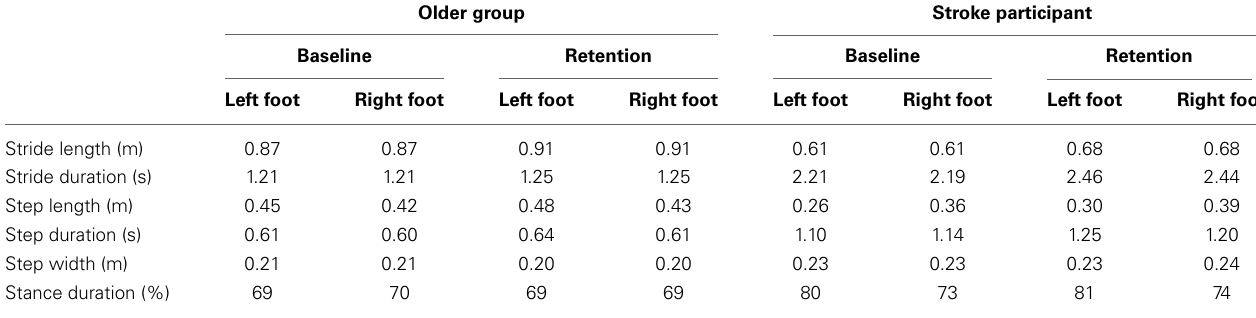
Table 1 | Gait cycle parameters for a group of older individuals and one stroke participant with an affected right